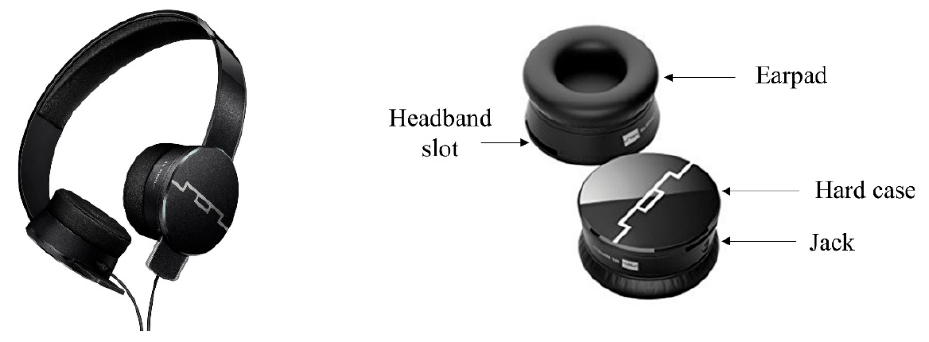
Figure 2. Headphone used as inspiration for the test case and parts identification.